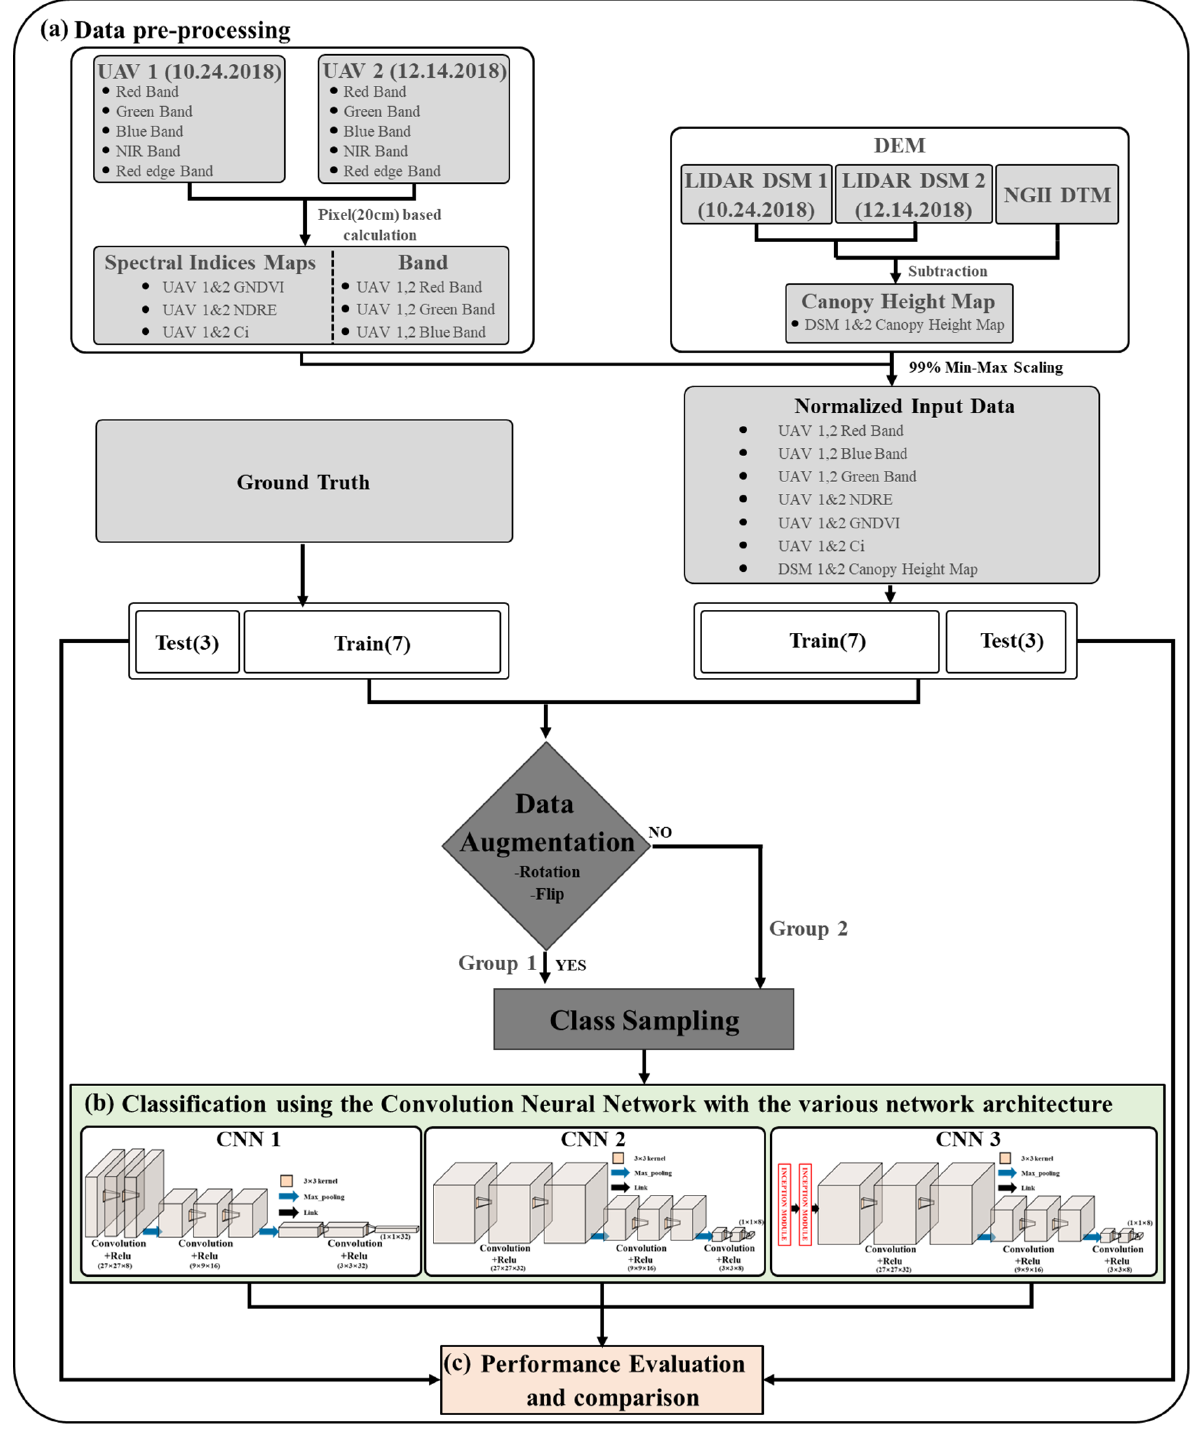
Figure 2. Data flow of research.